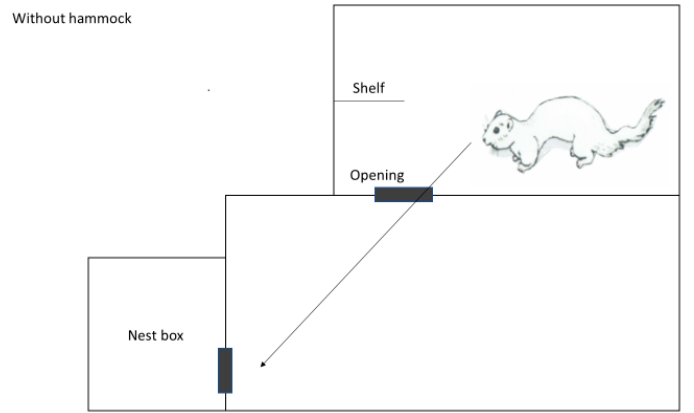
Figure 1. Standard multilevel mink cage (control), view from the left side. The arrow indicates the chosen route of the mink from the upper floor to the nest box. Animals 2018 , 8 , x